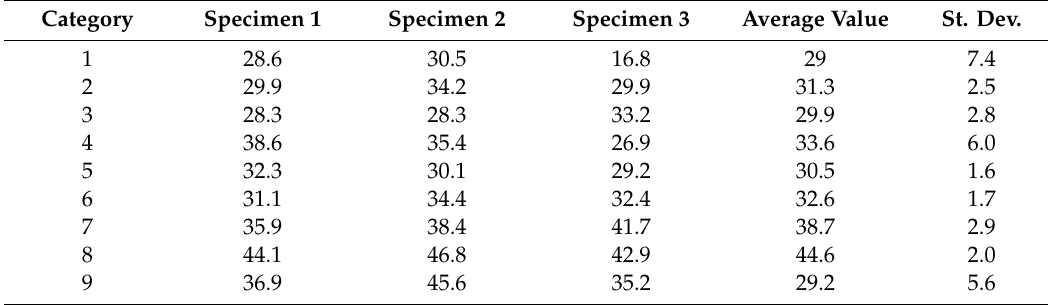
Table 1. Experimental tensile strength (MPa) for the di ff erent specimens.